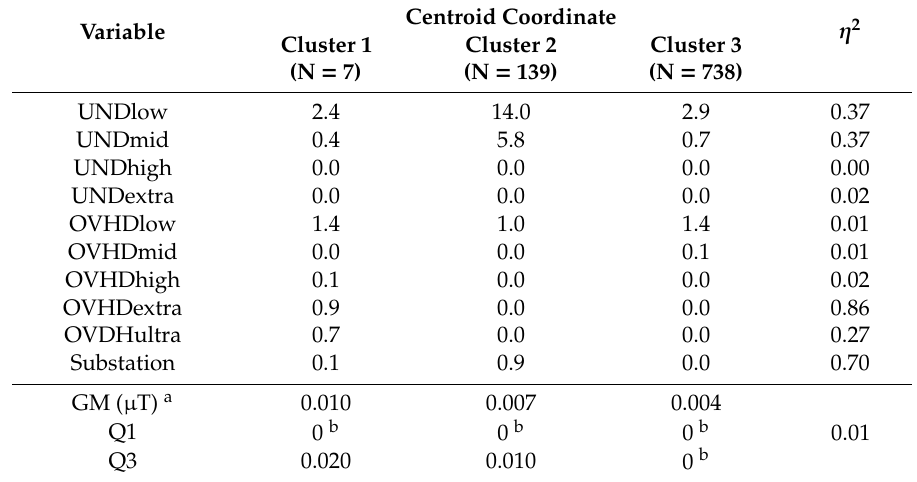
Table 4. Cluster model for the harmonic component of magnetic field exposure. For details, see Table 2. Centroid Variable